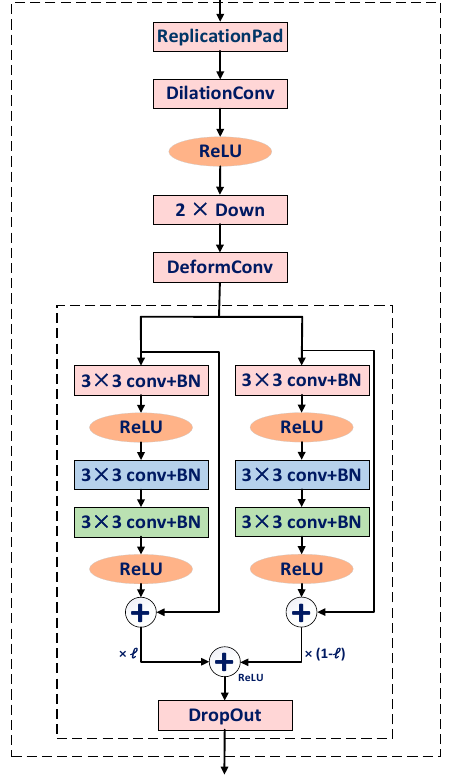
Figure 2. DR encoder structure diagram.